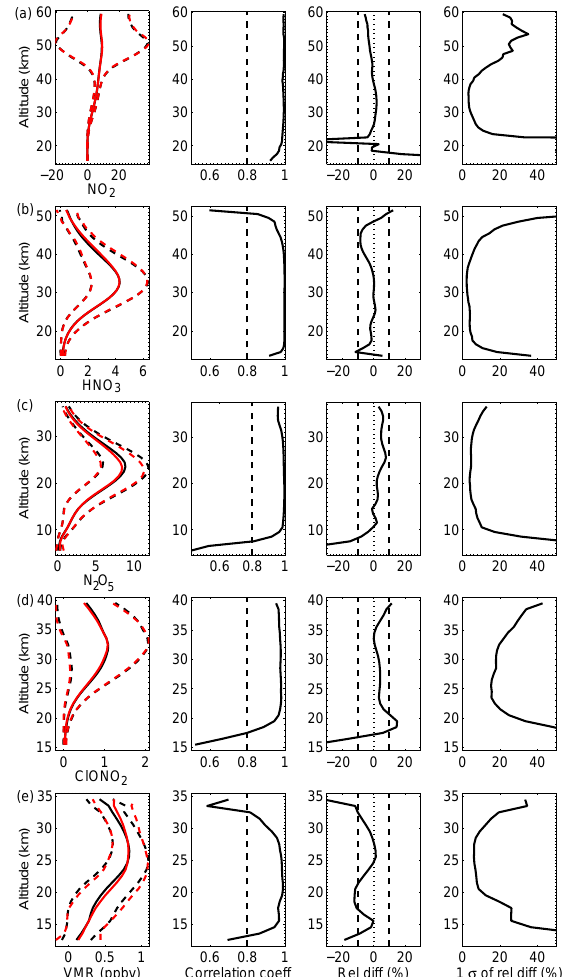
Figure 2. Direct comparisons of ACE-FTS v2.2 with ACE-FTS v3.5 (a) NO, (b) NO 2 , (c) HNO 3 , (d) N 2 O 5 , and (e) ClONO 2 . From left to right the panels show the mean concentration profiles (red solid for v2.2, black solid for v3.5) with corresponding 1 σ (red dashed for v2.2, black dashed for v3.5) in parts per billion volume (ppbv), correlation coefficient profiles, the mean of the percent dif- ferences (v3.5 − v2.2 divided by the mean v2.2 profile), and standard deviation of the percent differences. Dashed lines in the correlation (at 0.8) and relative difference plots (at − 10, 0, and 10%) are pro- vided for visual clarity.